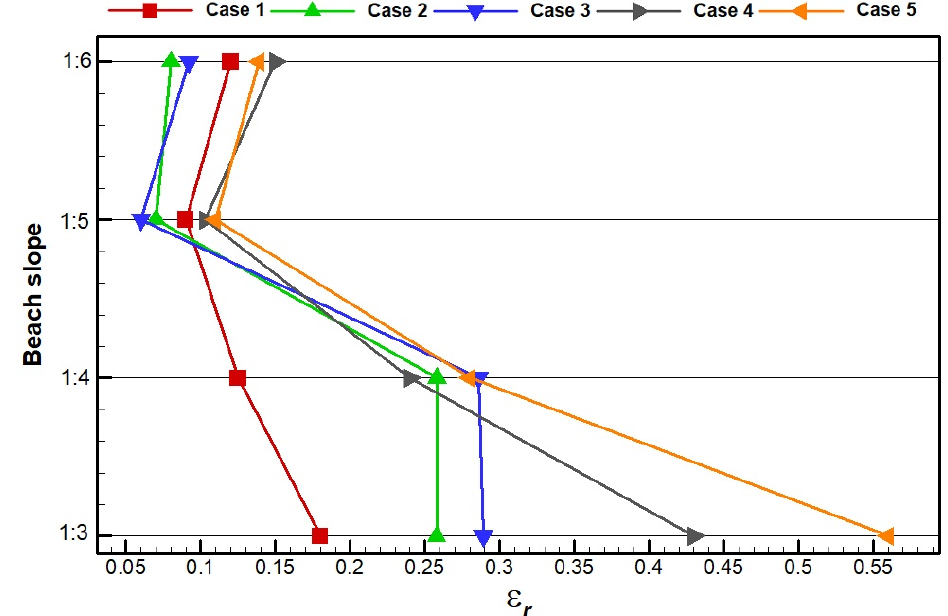
Figure 25. Results of the wave reflection coefficient for different beach slopes in different cases.